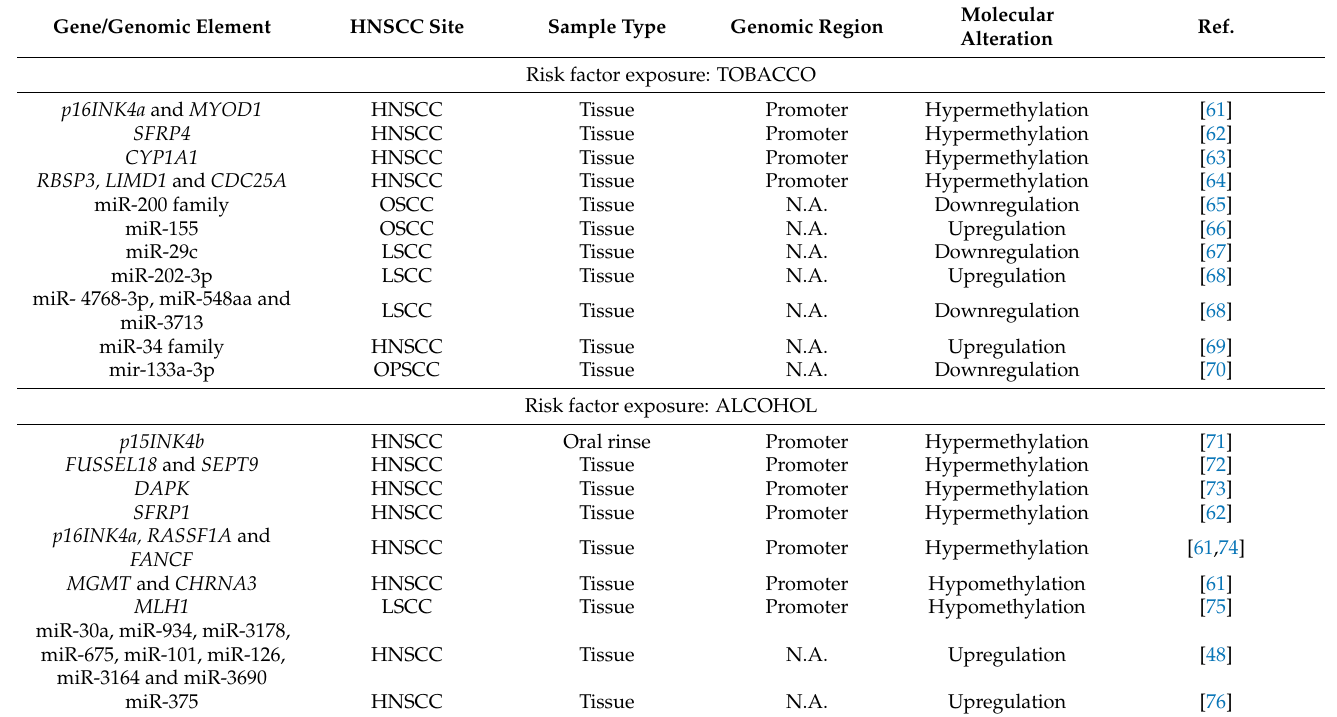
Table 1. Epigenetic biomarkers in head and neck squamous cell